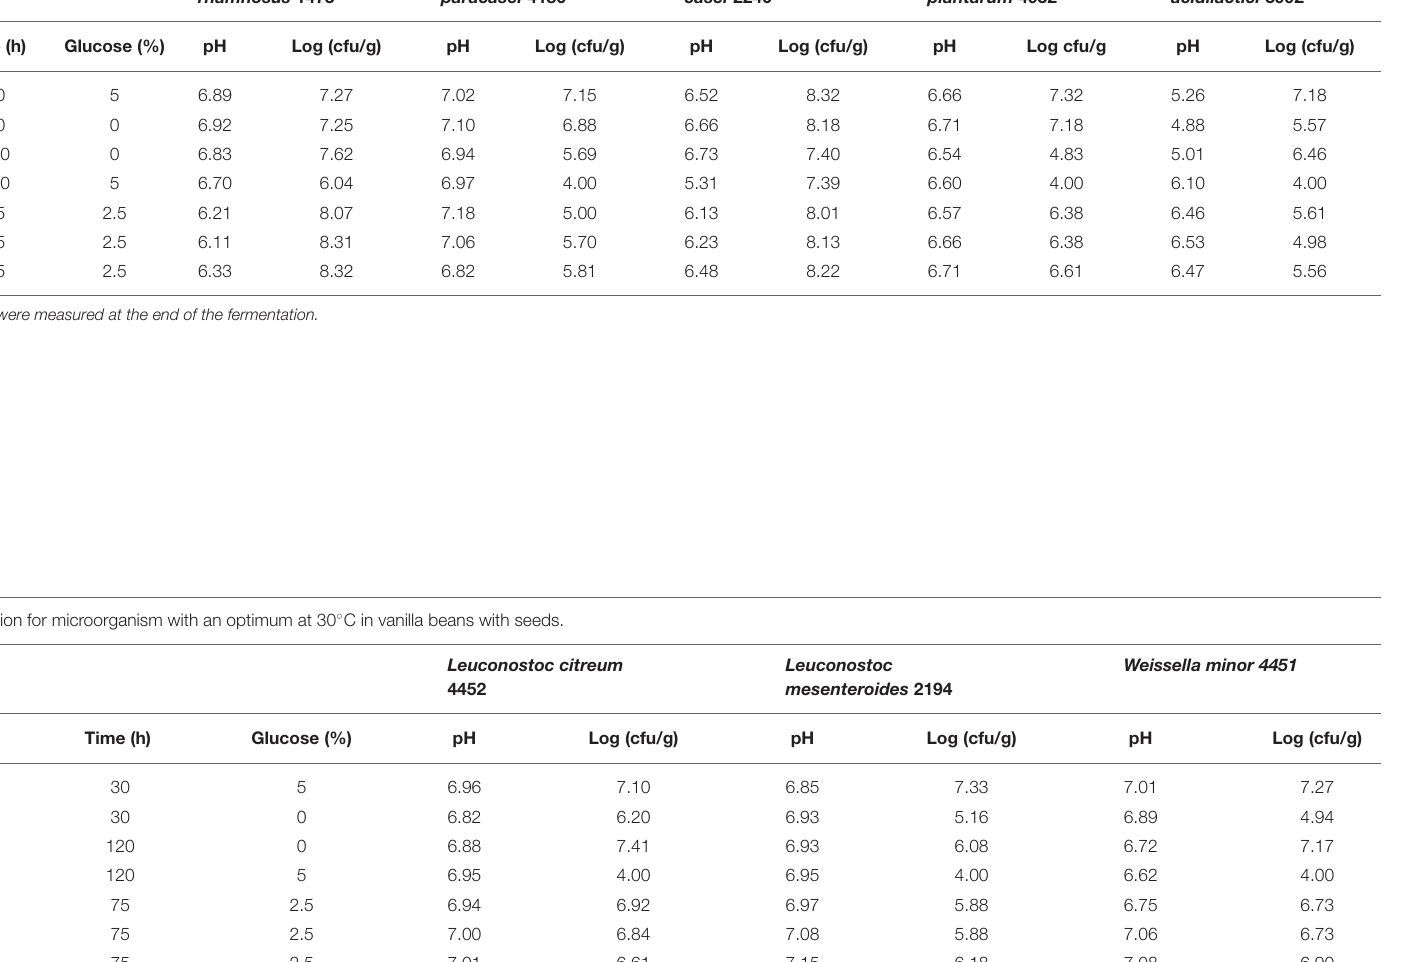
Leuconostoc citreum 4452